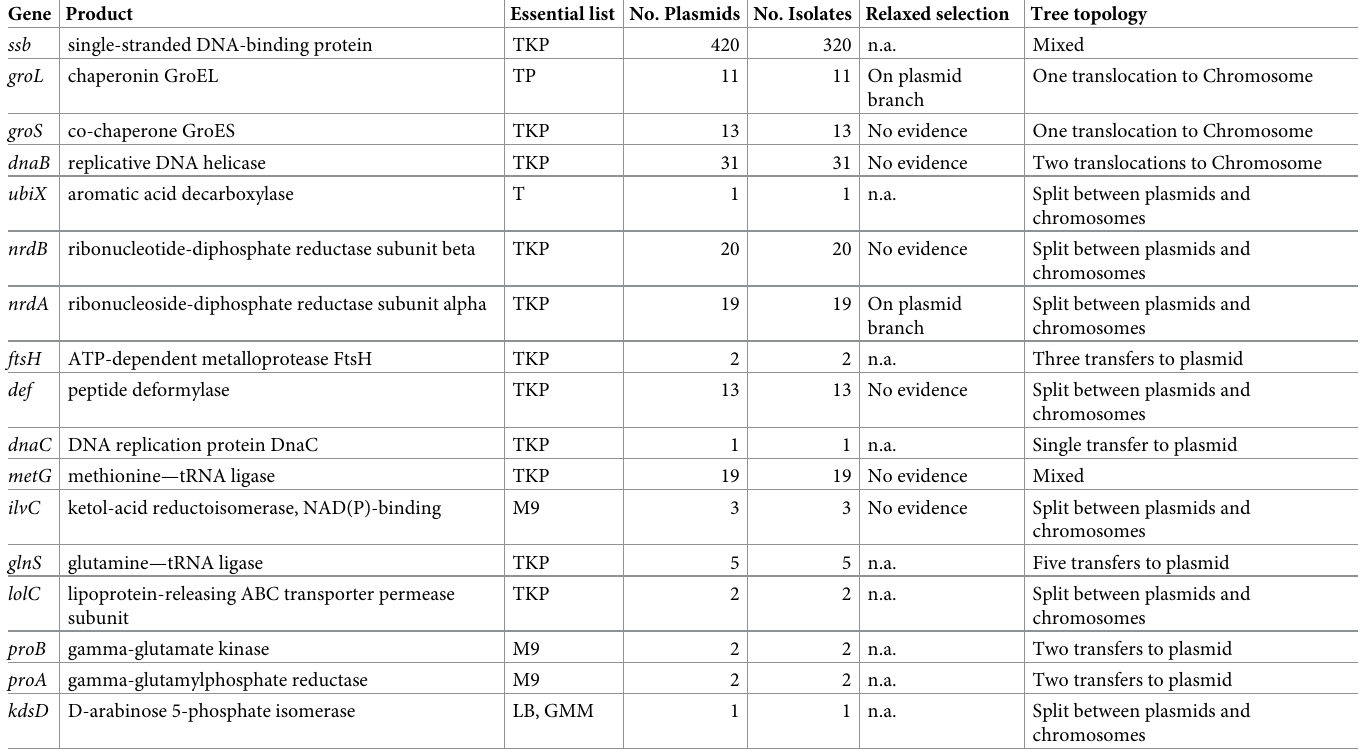
Table 1. Data and phylogenetic analysis of essential genes encoded on plasmids. Essential list indicates the source of essential genes: TKP is TraDIS-Keio-PEC, TP is TraDIS-PEC, T is TraDIS (Goodall et al. 2018); LB, M9 and GMM means this gene is essential in each of the three medias (Rousset et al. 2020). Relaxed selection shows evi- dence for relaxed selection on plasmid homologs’ branch was found using HyPhy-RELAX (Murrell et al. 2012). Tree topology shows the conclusions from the phylogenetic reconstruction of essential genes on plasmids and chromosomes: split between plasmids and chromosomes describe phylogenies that had a deep split between plasmid and chromosomal homologs (i.e., they are diverged); LGT events from chromosome to plasmid are labeled by transfer to plasmid ; LGT events from plasmid to chromosome are labeled by transfer to chromosome ; mixed is used to label phylogenies that contain deep divergence and LGT events. For gene trees with evidence for gene transfer ( groEL , groES ), we further tested the support in the plasmid/chromosome split while excluding the putatively transferred gene. In all tested cases the result showed that the constrained tree could not be rejected in a topology test, thus validating the gene transfer inference. All of the transfer event from plasmid to chromosome are better described as translocation of the plasmid homolog to